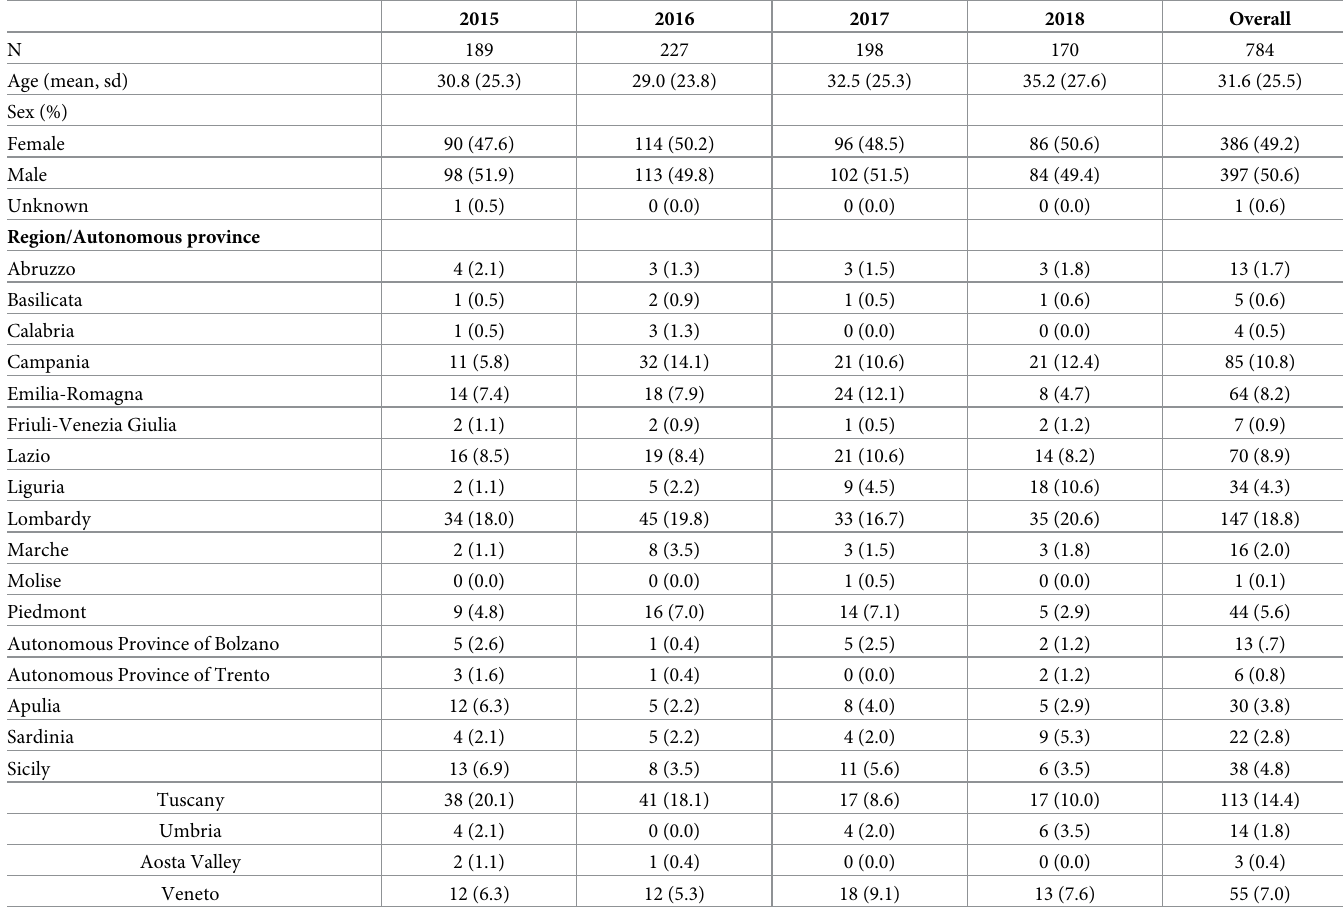
Table 1. Characteristics and distribution by region/autonomous province of the invasive meningococcal disease cases reported to the national surveillance system and included in the evaluation, Italy,